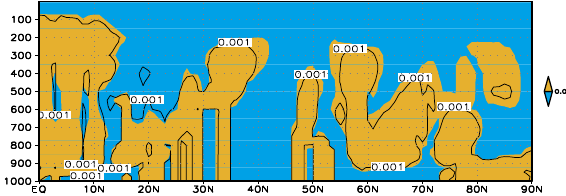
Figure 1. the longitude-vertical section along 100E of FCC (shaded, only 0.01 isoline is given) and condensed moisture (contour, only 0.001kg kg -1 isoline is given).